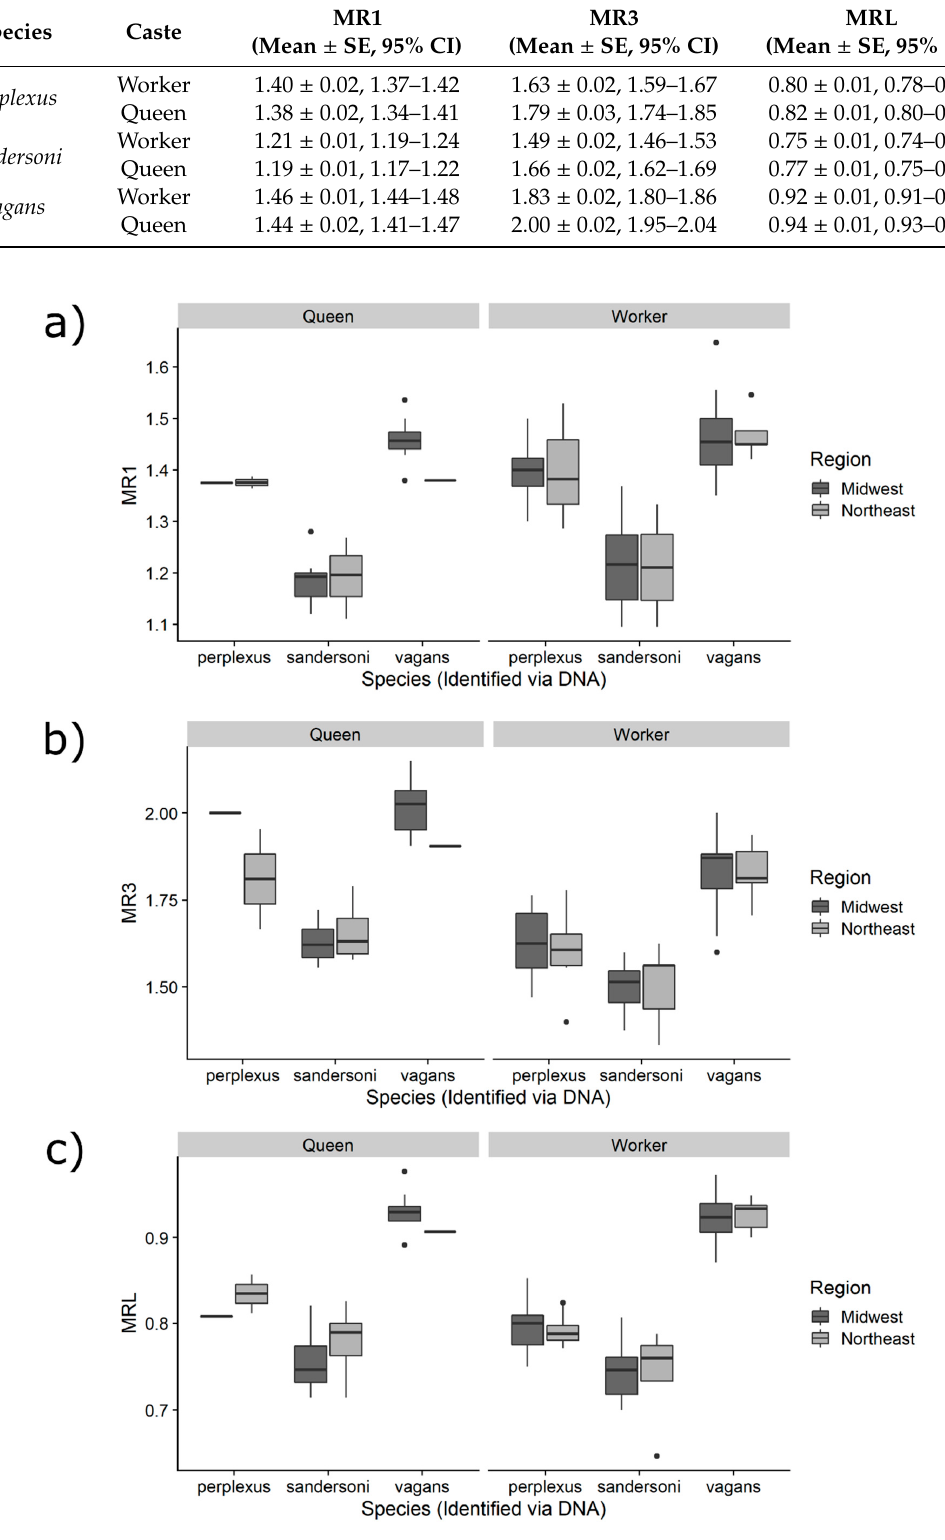
Figure 3. Comparison of malar ratios among the three Bombus species, caste, and between the regions for the following measurements: ( a ) MR1, ( b ) MR3 and ( c ) MRL.